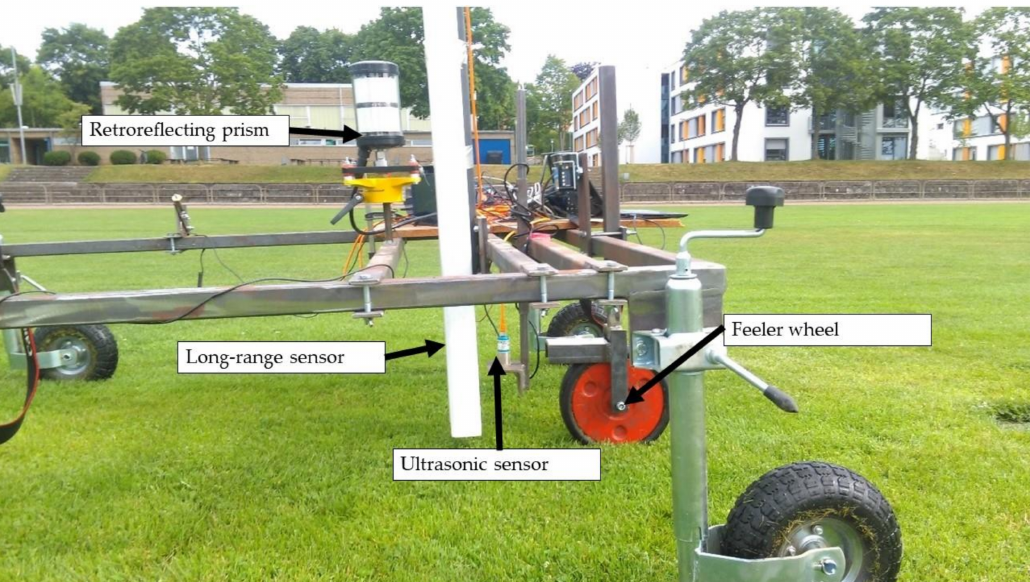
Figure 1. The measurement frame with the retroreflecting prism and the ultrasonic sensor, the feeler wheel and the long-range sensor. The retroreflecting prism has a distance measurement accuracy of ± (4 mm + 2 ppm). The ultrasonic sensor has an accuracy of ± 1%, with a resolution of more than 0.18 mm. The long-range sensor has an accuracy of ± 3 mm. The displacement of the feeler wheel according to the measurement frame was measured with an accuracy of ± 10 mm by a midrange distance